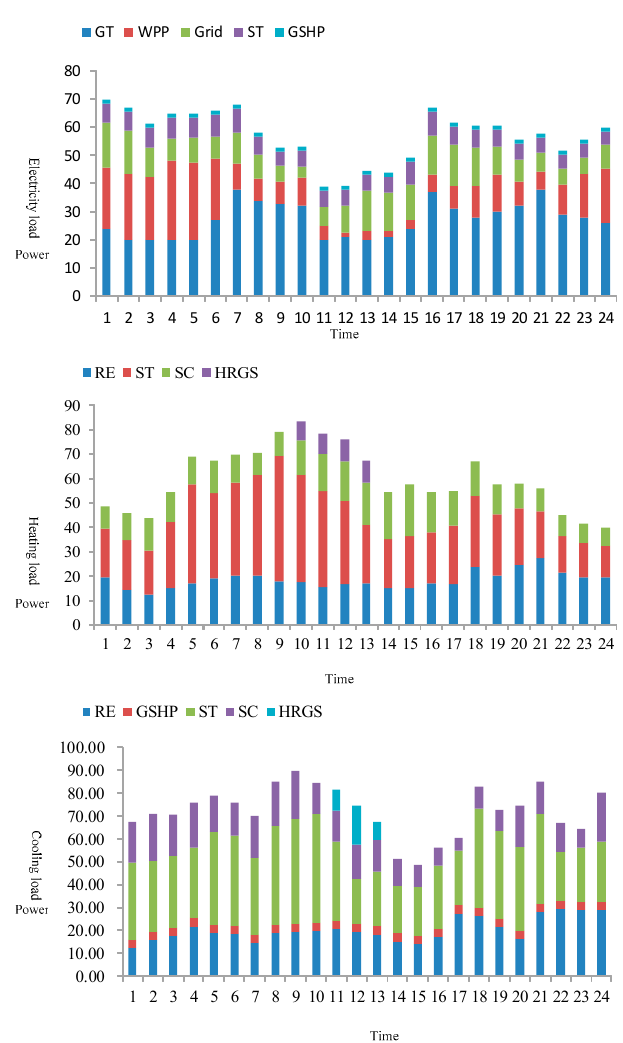
Figure 9. Hourly electric, heating, and cooling load supply of scenario 5 (unit: MW).